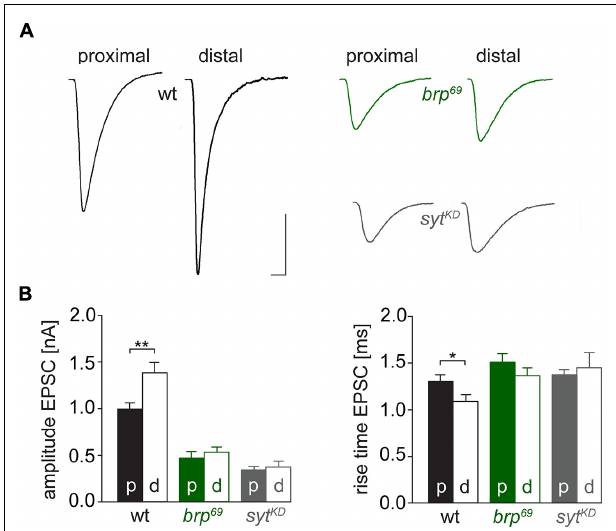
FIGURE 6 | Functional differentiation of proximal and distal type Ib boutons. (A) Averaged EPSCs elicited by 0.2 Hz nerve stimulation in physiological solution containing 0.5 mM [Ca 2 + ] Ex and recorded focally from proximal and distal type Ib boutons in wt (black), brp 69 (green) and syt KD (gray). Scale bars = 0.5 ms, 1 nA. (B) Summary bar graphs for EPSC amplitudes and current rise times (mean ± SEM) for the three genotypes with p, proximal and d, distal, color coded like in (A) .